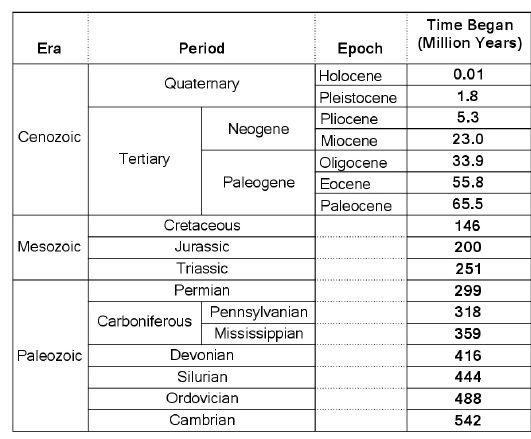
Figure 1: Geological time